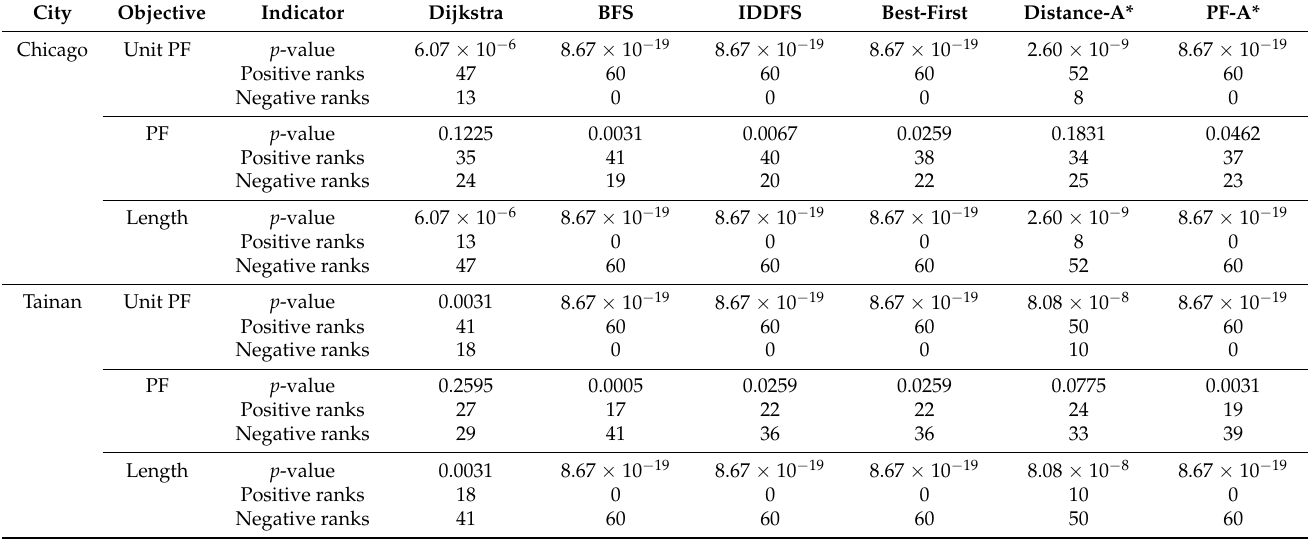
Table 11. Wilcoxon signed-rank test for BiasSpan against different methods towards all objectives.